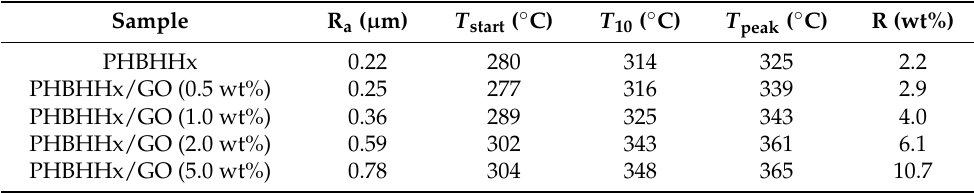
Table 1. Roughness and thermal stability data of PHBHHx/GO nanocomposites.